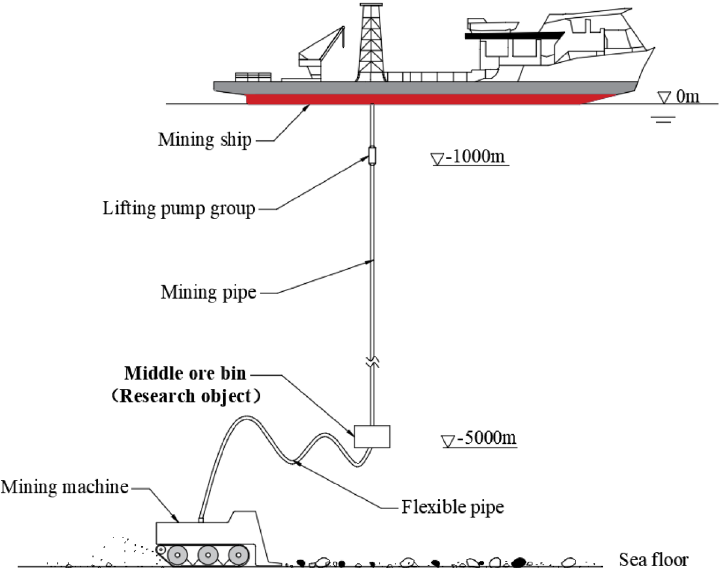
Figure 1. Schematic diagram of deep sea mining system